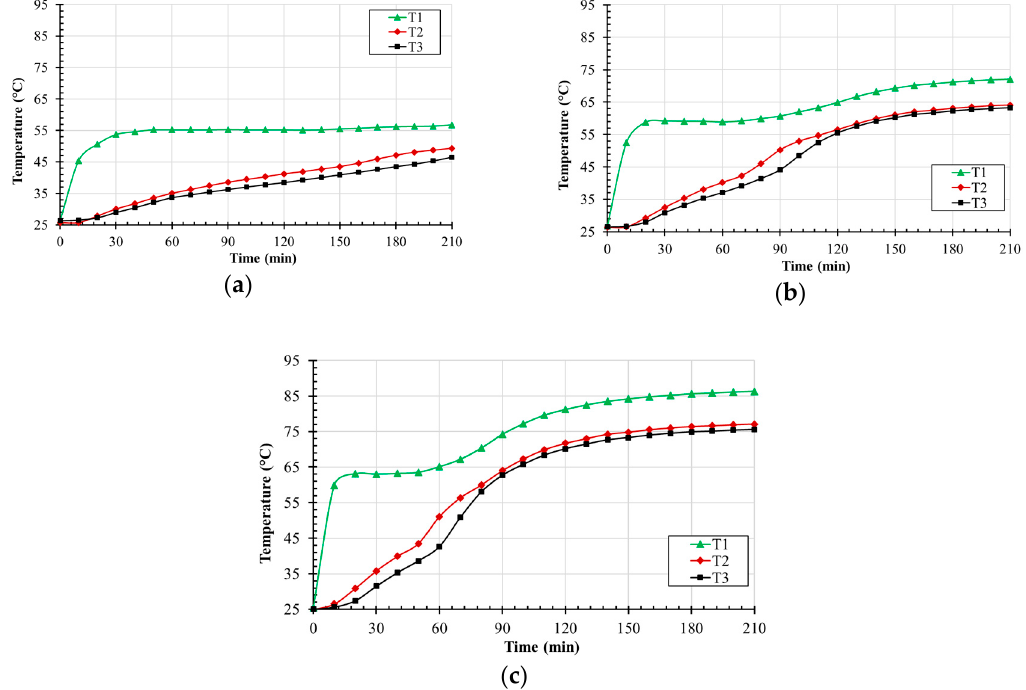
Figure 6. Temperature distribution across the heat sink A for RT47 at power rating, ( a ) 1.0 W, ( b ) 1.5 W and ( c ) 2.0 W.